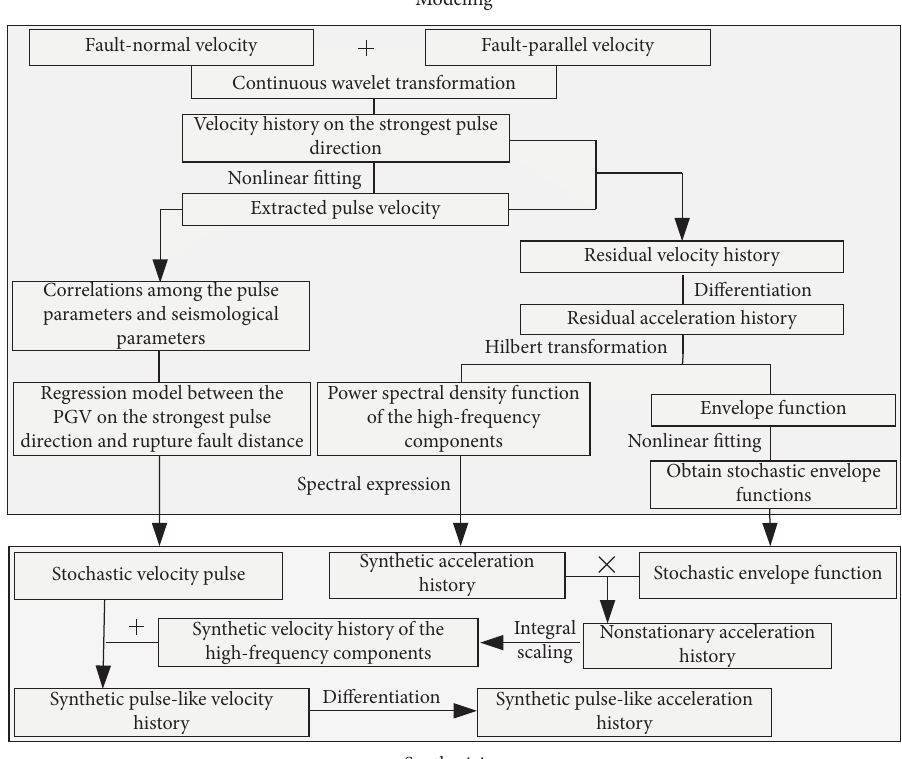
Figure 1: Stochastic modeling and artificial synthesizing method of the near-fault pulse-like ground motions.